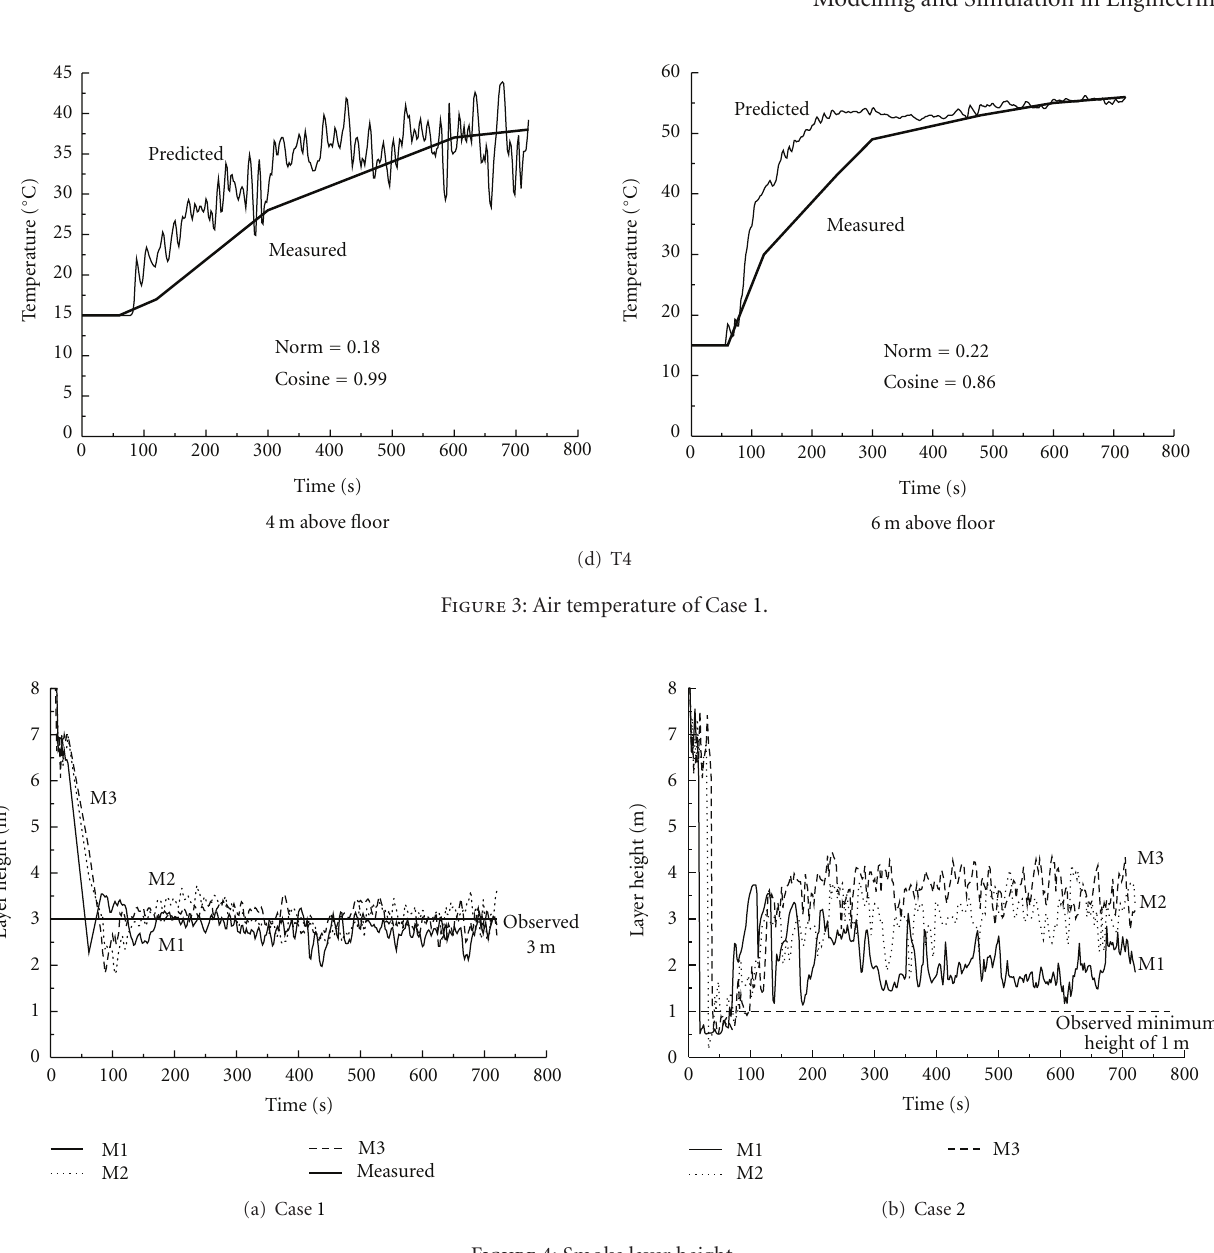
Figure 4: Smoke layer